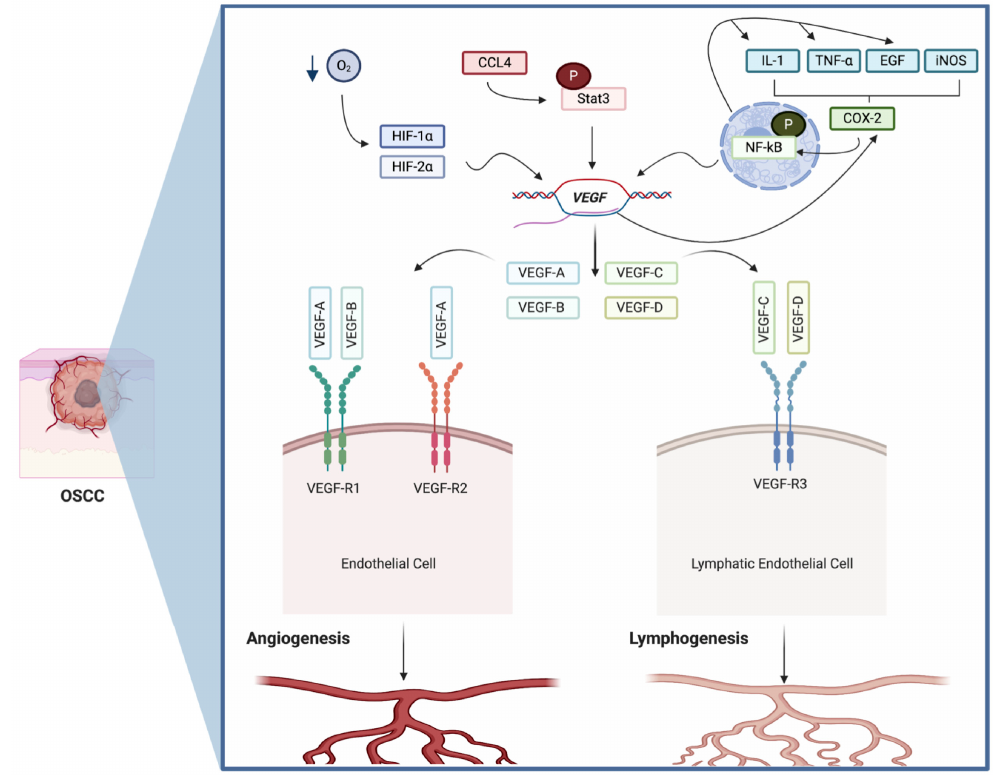
Figure 1. Role of VEGF signaling in OSCC. VEGF is constitutively expressed in oral squamous cell carcinoma. Its secretion can be the result of the activation of different signaling pathways, which includes: (1) the production of hypoxia inducible and HIF ‐ 2 α by low oxygen levels, (2) the activation of Stat3 by CCL4 (which is constitutively expressed in OSCC) and (3) the activation of COX2 by different inflammatory molecules (commonly overexpressed in OSCC) which activate the NF ‐ kB pathway. The activation of these pathways leads to the transcription of all four variants of VEGF (A–D), which through the activation of VEGF ‐ R1, VEGF ‐ R2 and VEGF ‐ 3 on blood and lymphatic endothelial cells, induces angio ‐ and lympho ‐ genesis. Created with BioRender.com.